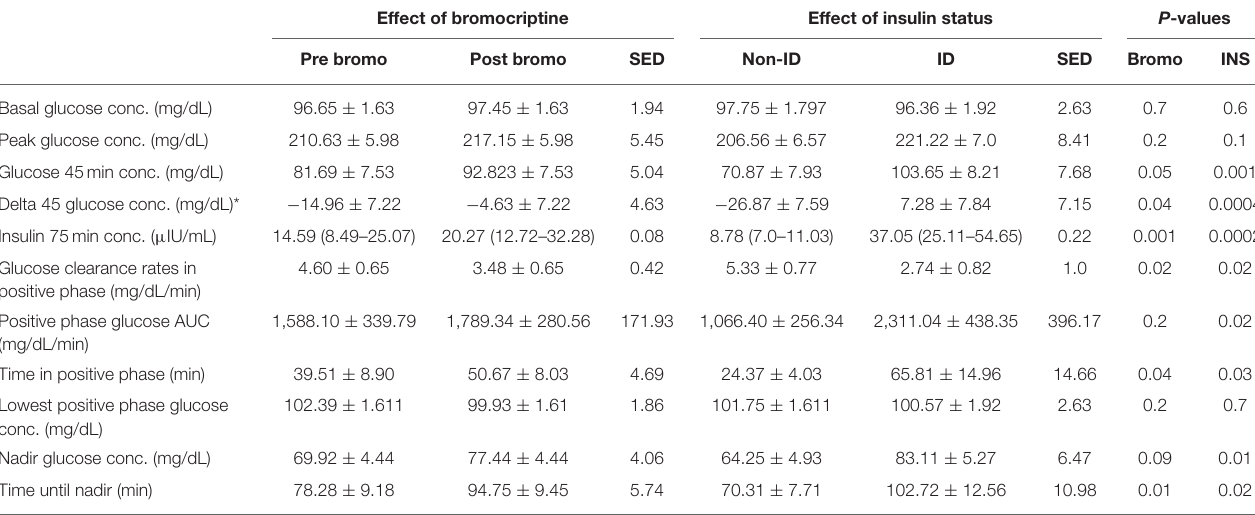
TABLE 5 | Effect of bromocriptine and insulin status on CGIT